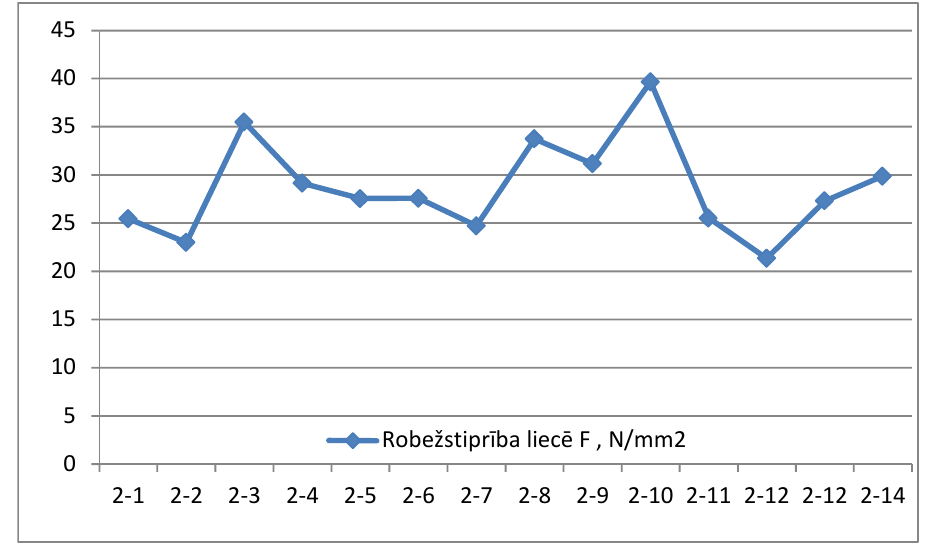
Figure 4. Borderline flexural strength N/mm 2 measurement graph for samples of group No. 2. 3. Samples of group No. 3. Average size of the sample 297.44 × 101.60 mm 2 (see Table 3). Table 3. Characteristic values of borderline flexural strength. Group 3 (load applied on the narrowest face).